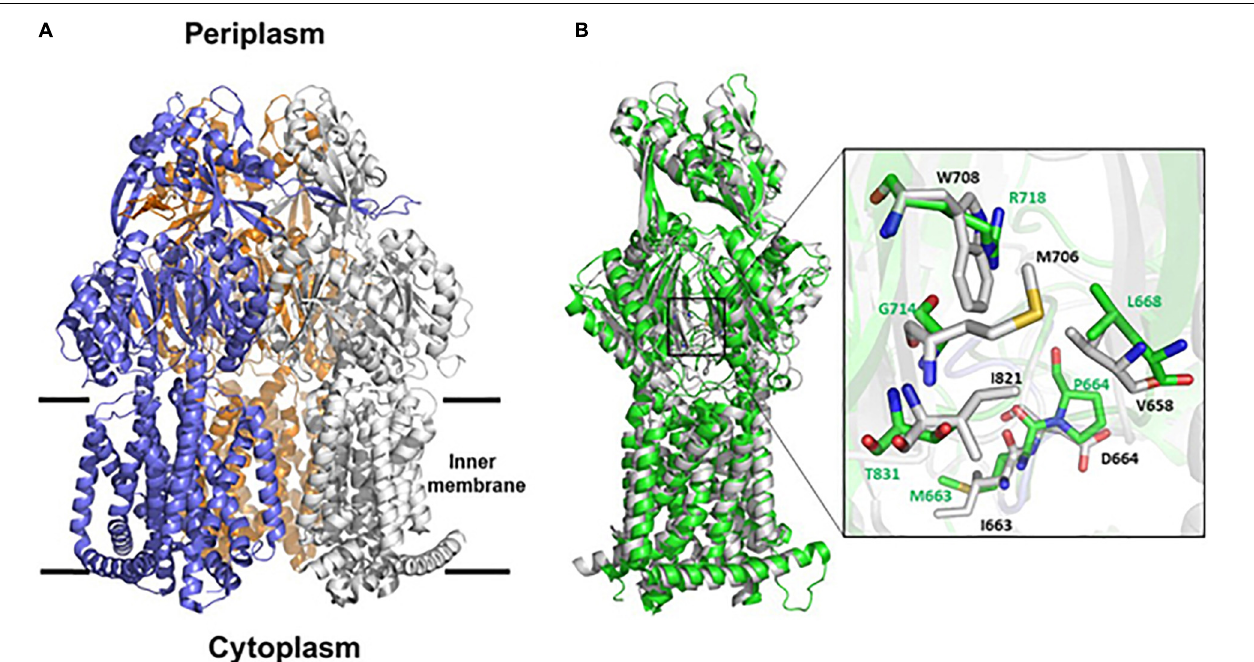
FIGURE 4 | Structural representation of AdeB and AdeJ pumps of A. baumannii . (A) Cartoon representation of AdeB heterotrimer (pdb code 7 kgd); the three protomers are represented in blue, white and orange. (B) Superposition between the structures of AdeB and AdeJ (pdb code 7m4q) protomers. The two structures superpose with a backbone root mean square deviations (rmsd) of 2.5, 2.9, 3.0 Å on chains A, B, and C, respectively. The inset shows a zoom of the entrance sites of AdeB (white) and AdeJ (green). AdeB residues are labeled black whereas corresponding AdeJ residues are labeled